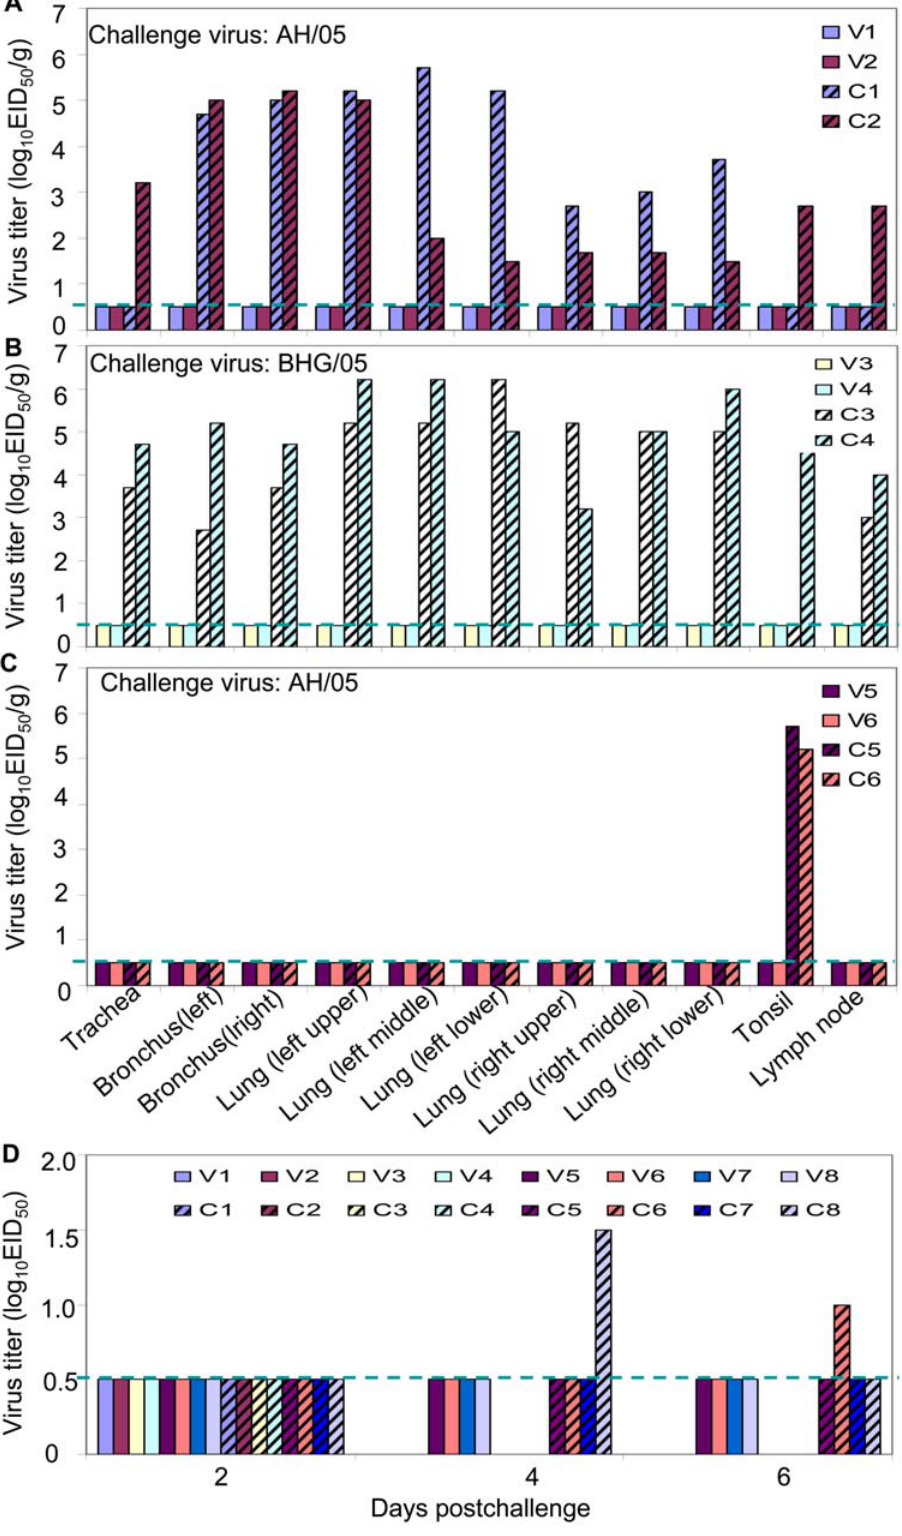
Figure 6. Viral replication in nonhuman primates. Virus titers were determined in embryonated eggs injected with tissue homogenates on day 3 (A,B) and day 15 (C) postchallenge with AH/05 virus or BHG/05 virus. Virus was not detected in tissues harvested day 15 postchallenge from animals challenged with the BHG/05 virus (data not shown). Titers are reported for tissues from individual animals, as log 10 EID 50 /g tissue. The dashed blue lines indicate the lower limit of detection. (D) Nasal swabs were collected from all living animals on days 2, 4, and 6 postchallenge for virus isolation in eggs. doi:10.1371/journal.ppat.1000409.g006 PLoS Pathogens |